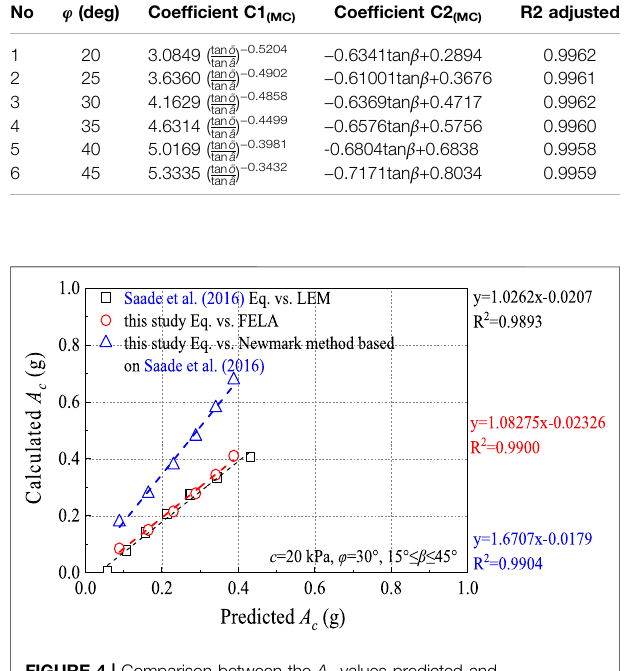
FIGURE 4 | Comparison between the A c values predicted and calculated with the LEM, Newmark method, and FELA for c = 20 kPa, φ = 30 ° and 15 ° ≤ β < 45 ° .